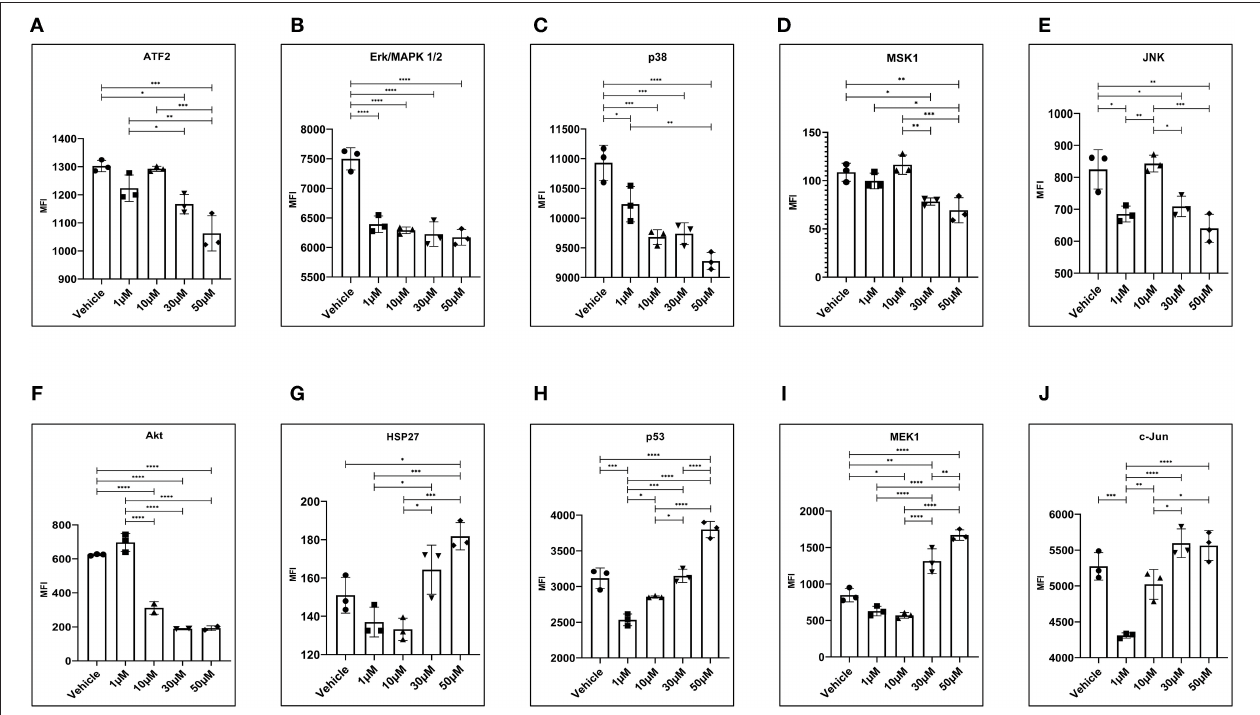
FIGURE 3 | MAPK and Akt protein kinases are significantly altered in 12Z cells treated with WIN 55. (A-F) Total protein obtained from 12Z cells treated with WIN 55 showed significantly lower levels of ATF2, Erk 1/2, p38, MSK1, JNK, and Akt. (G-I) On the other hand, protein levels of HSP27, p53, and MEK1 were significantly higher in the cells treated with WIN 55. (J) Although a positive trend was noticed, c-Jun levels did not show significant changes when compared with cells treated with vehicle, apart from 1 µ M concentration. Ordinary one-way ANOVA with Tukey post-hoc . * P < 0.05 ** P < 0.01 *** P < 0.001 **** P <